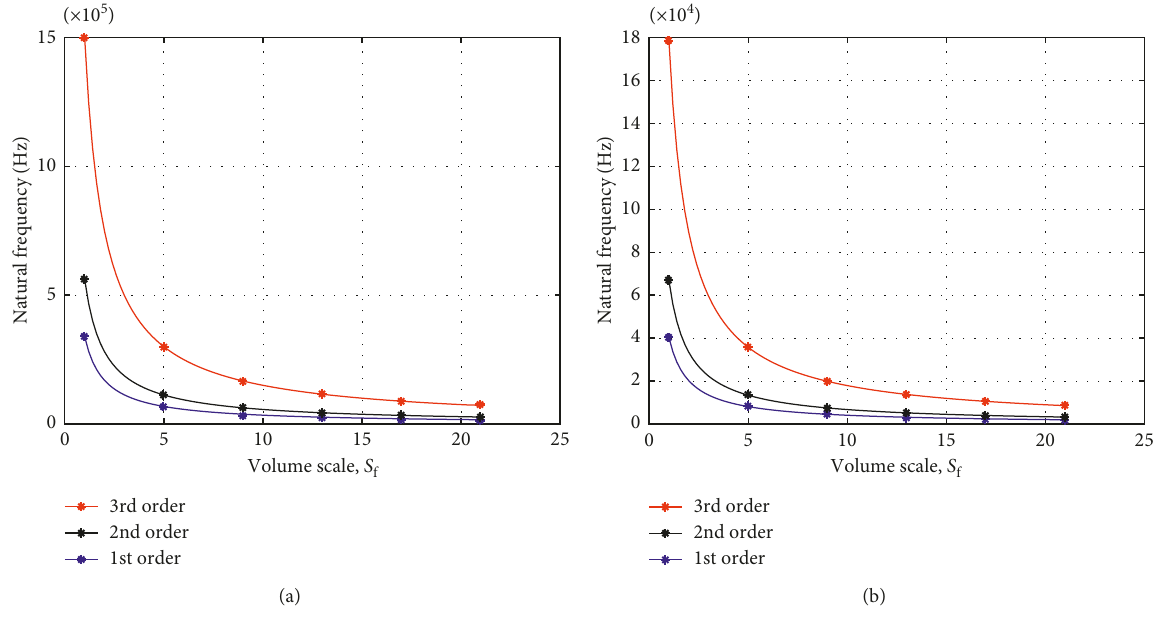
Figure 4: Natural frequencies versus volume scale. (a) Silicon. (b)